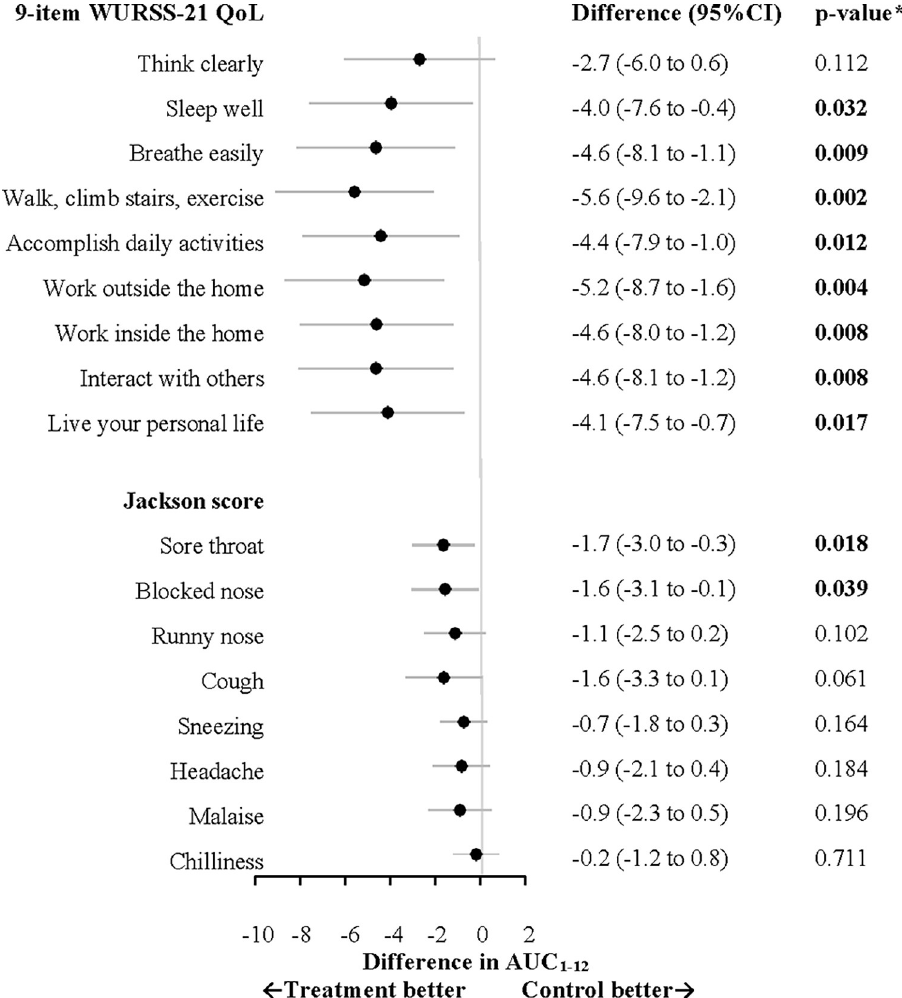
Fig 2. Forest plot analyses of individual items of 9-item WURSS-21 QoL domain and 8-item Jackson symptom